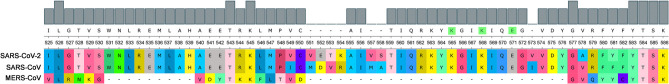
Comparison of SUD domain M region in three pathogenic human coronaviruses. Nsp3 proteins of three pathogenic human viruses (SARS-CoV-2, SARS-CoV, and MERS-CoV) were aligned and part of the critical G-quadruplex binding M region of the SUD domain (525–577 aa according to the SARS-CoV reference sequence) was visualized. As predicted according to Kusov et al. (2015), the G-quadruplex-interacting residues K565, K568, and E571 are highlighted in green (upper consensus panel).